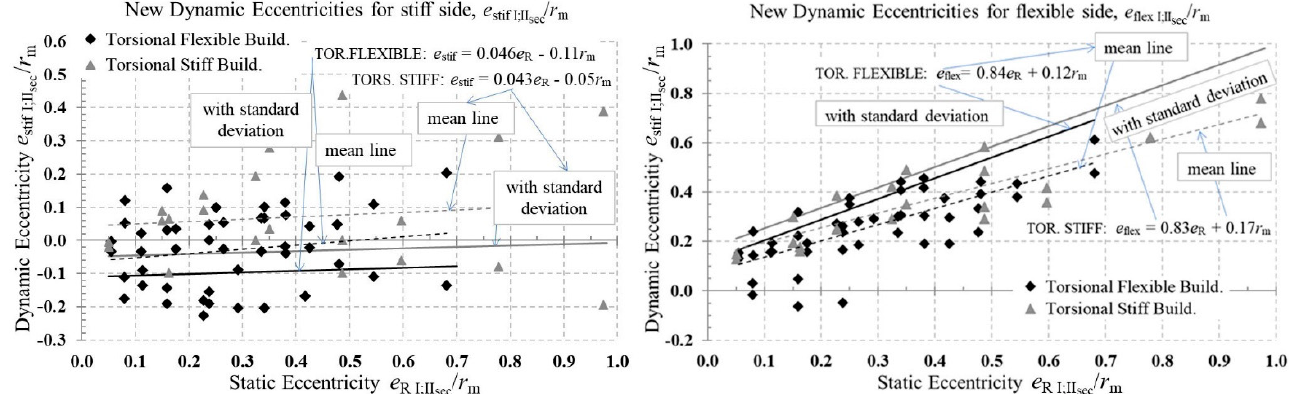
Figure 3. Normalized inelastic dynamic eccentricities, left: 𝑒 (cid:2929)(cid:2930)(cid:2919)(cid:2916) (cid:2893);(cid:2893)(cid:2893)(cid:2929)(cid:2915)(cid:2913) 𝑟 (cid:2923) ⁄ for the stiff side, right: 𝑒 (cid:2916)(cid:2922)(cid:2915)(cid:2934) (cid:2893);(cid:2893)(cid:2893)(cid:2929)(cid:2915)(cid:2913) 𝑟 (cid:2923) ⁄ for the flex- ible side.